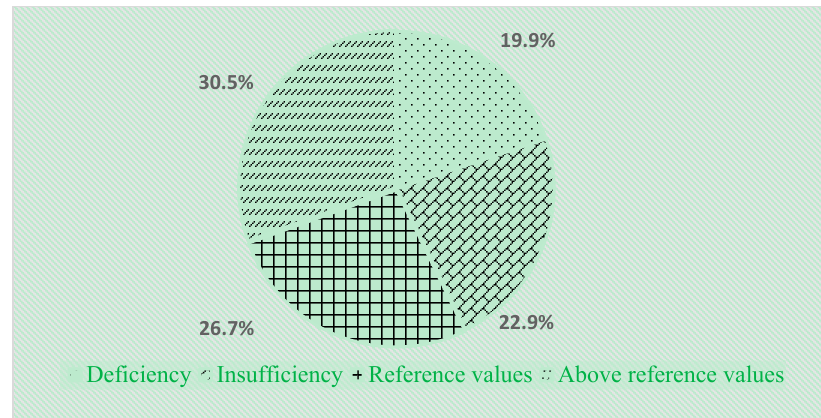
Figure 1. Serum level of vitamin 25(OH)D in young soccer players permanently residing in Moscow grouped by status. Table 1. Anthropometric characteristics and body composition in groups of athletes with serum concentration of 25(OH)D below 30 ng / mL and above 60 ng / mL.